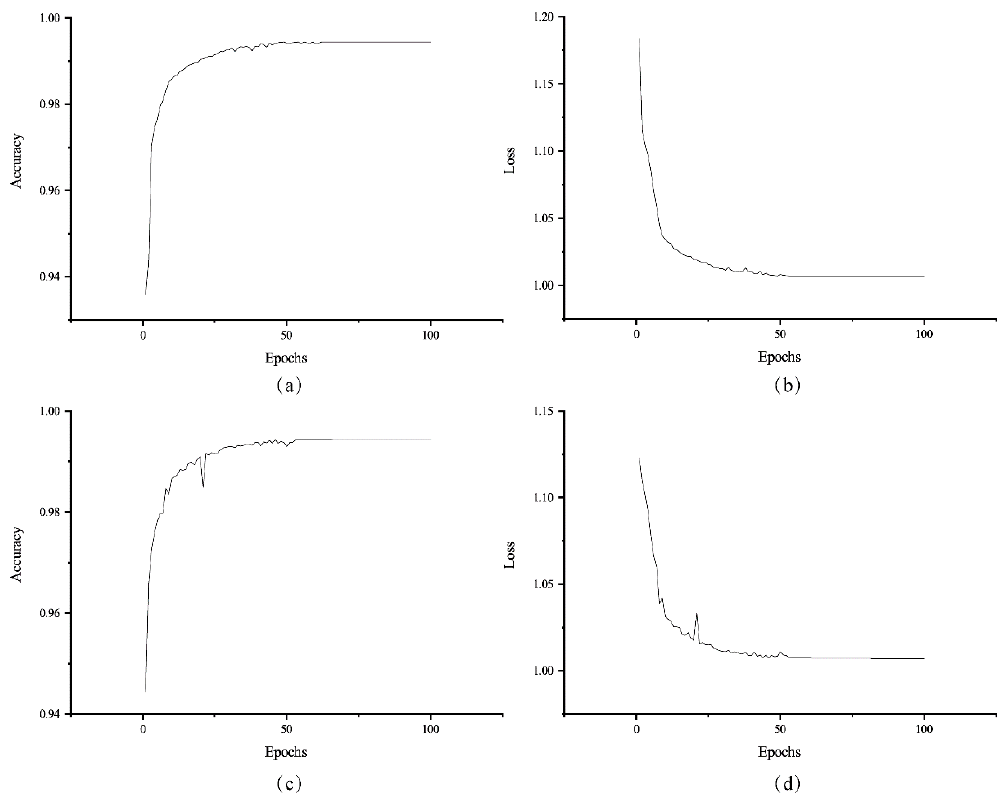
Figure 9. Accuracy and loss of ME-Net for training the datasets. The training accuracy ( a ) and loss ( b ) change with the epochs on the training datasets. The validating accuracy ( c ) and loss ( d ) change with the epochs on the validating datasets.